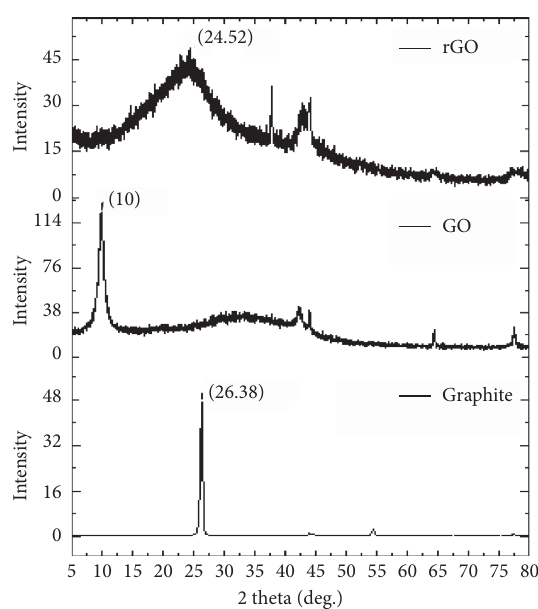
Figure 4: X-ray diffraction patterns of graphite, GO, and